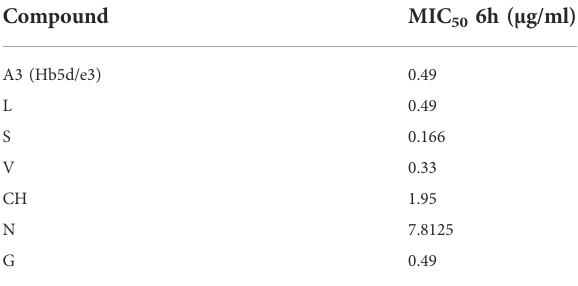
TABLE 3 Standardization of antibiotic concentrations based on MRSA growth suppression (50%) at different time points of culture.